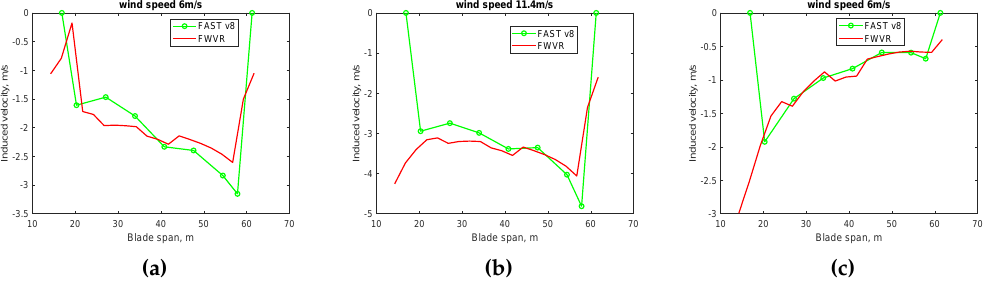
Figure 7. The axial induced velocities at wind speeds 6 m/s ( a ), 11.4 m/s ( b ) and 18 m/s ( c